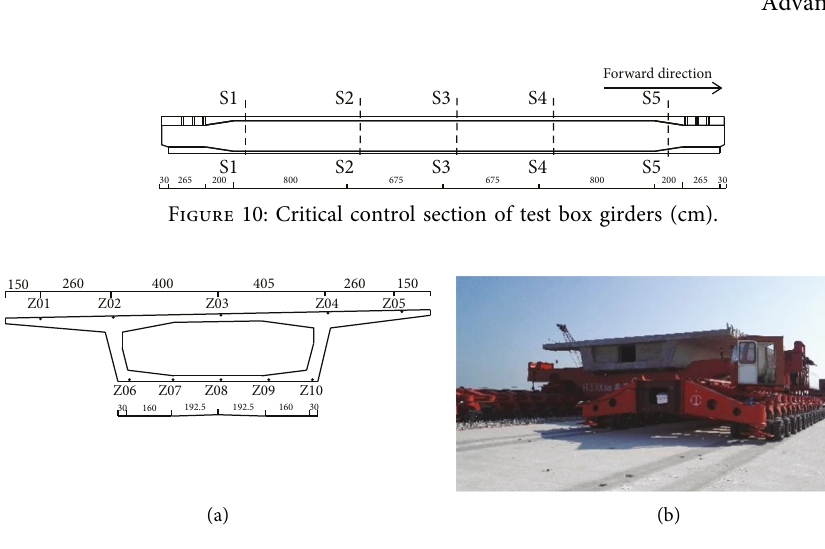
Figure 11: Tracking test of 40 m bearing box girder. (a) Stress measuring points arrangement (cm). (b) The field loading